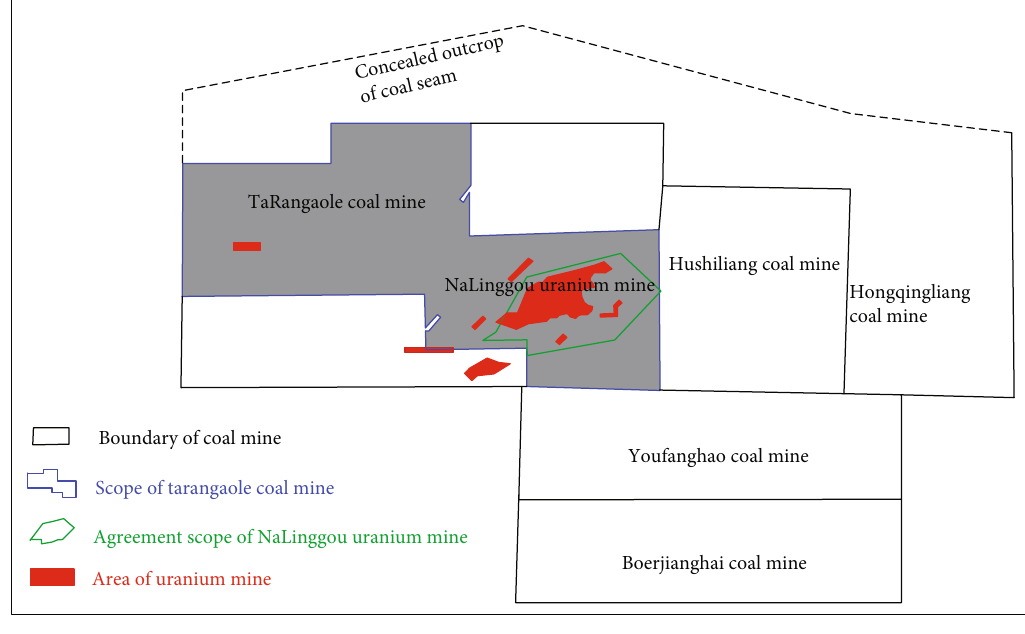
Figure 1: The spatial distribution of coal and uranium in the Ordos Basin.